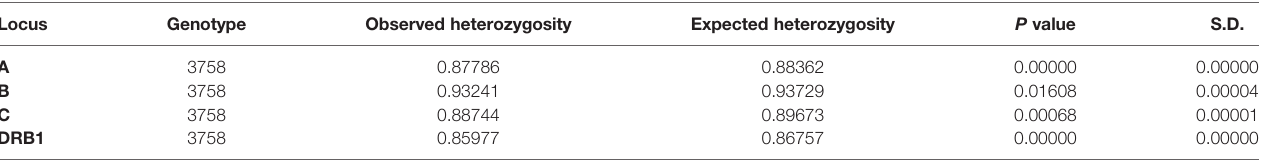
TABLE 3 | Hardy – Weinberg equilibrium with an exact test using a Markov chain.